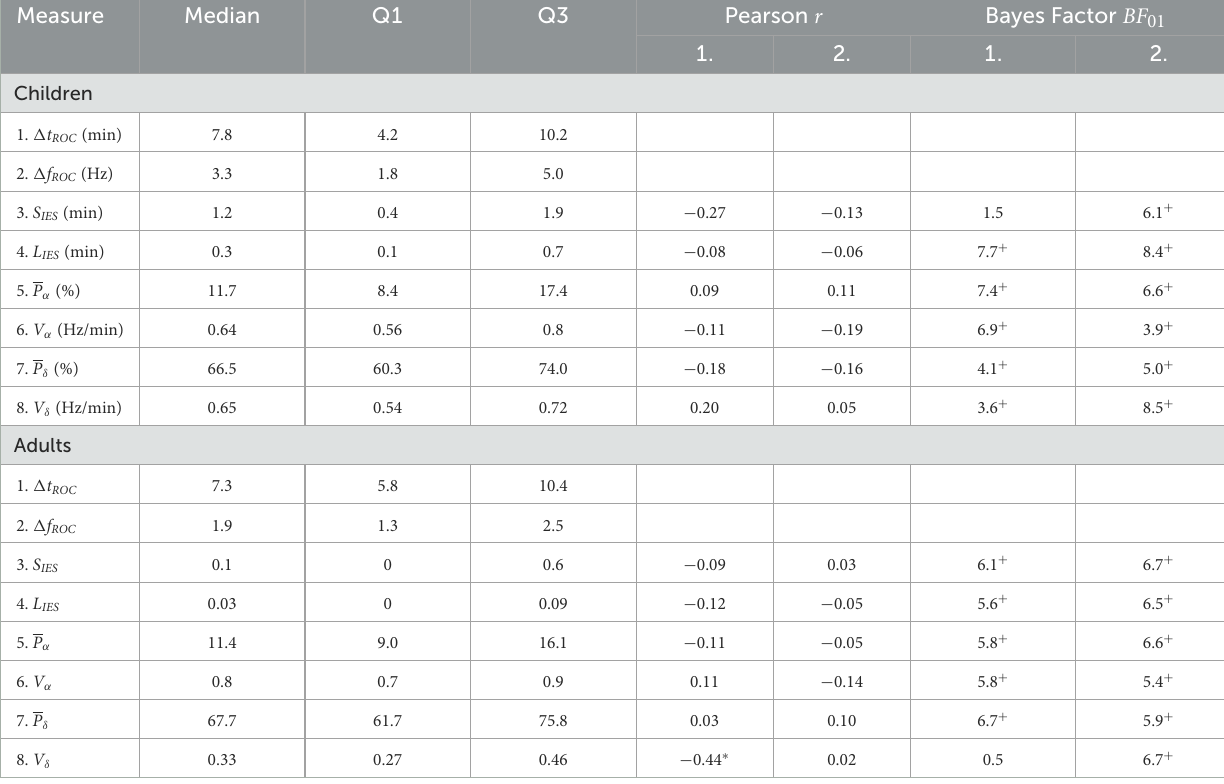
TABLE 2 Medians, inter-quartile ranges, Pearson correlations, and Bayes factor of EEG statistical features. Measure Median Q1 Q3 Pearson